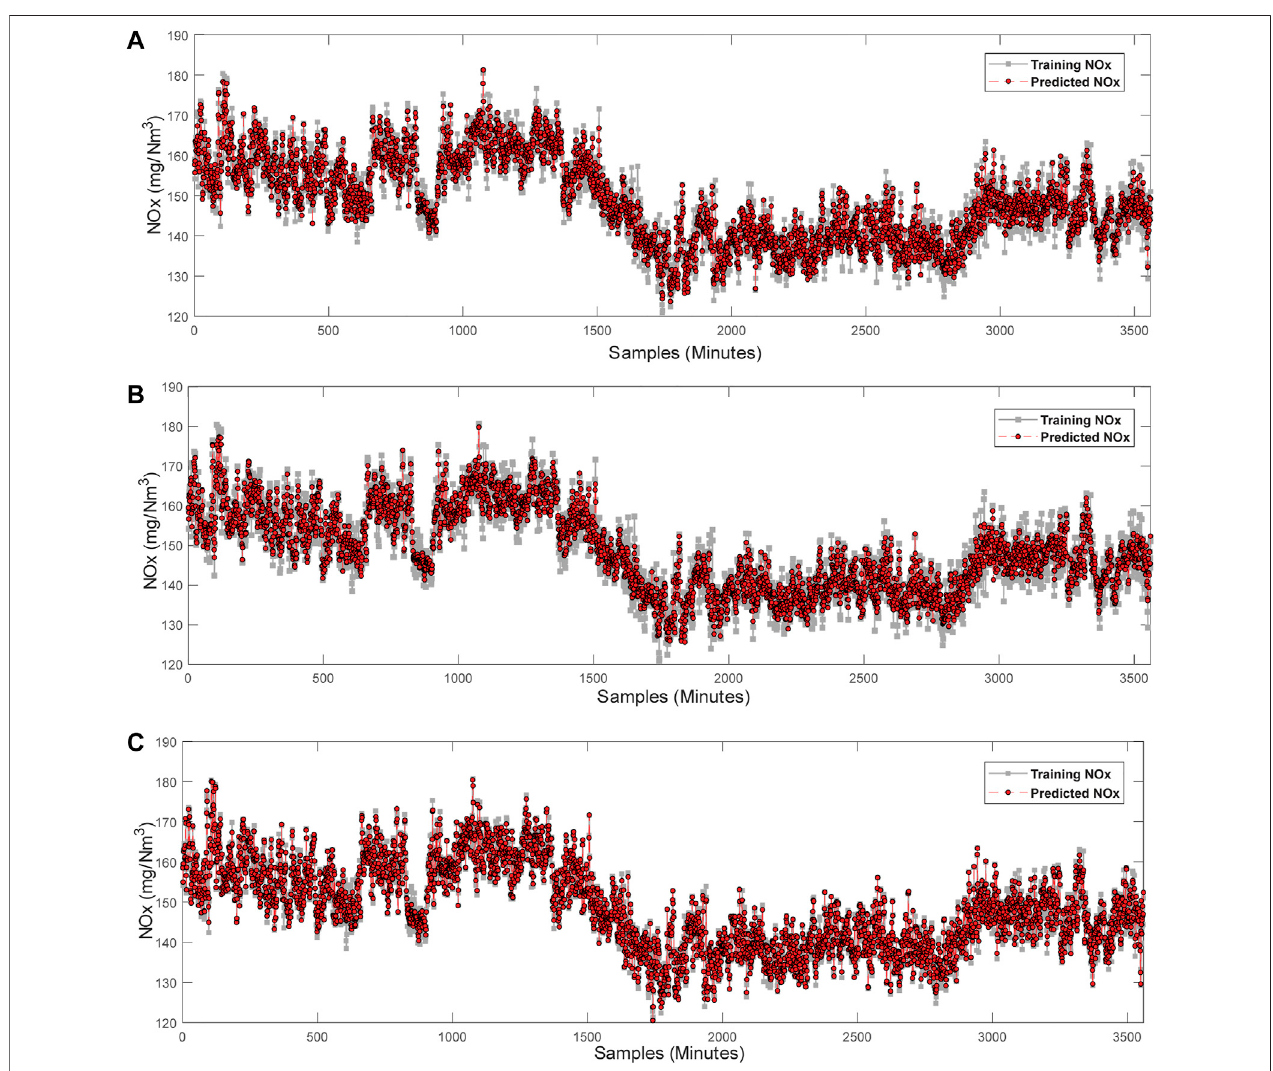
FIGURE 8 | (A) LSTM training data NOx prediction. (B) GRU training data NOx prediction. (C) 1D-CNN training data NOx prediction.